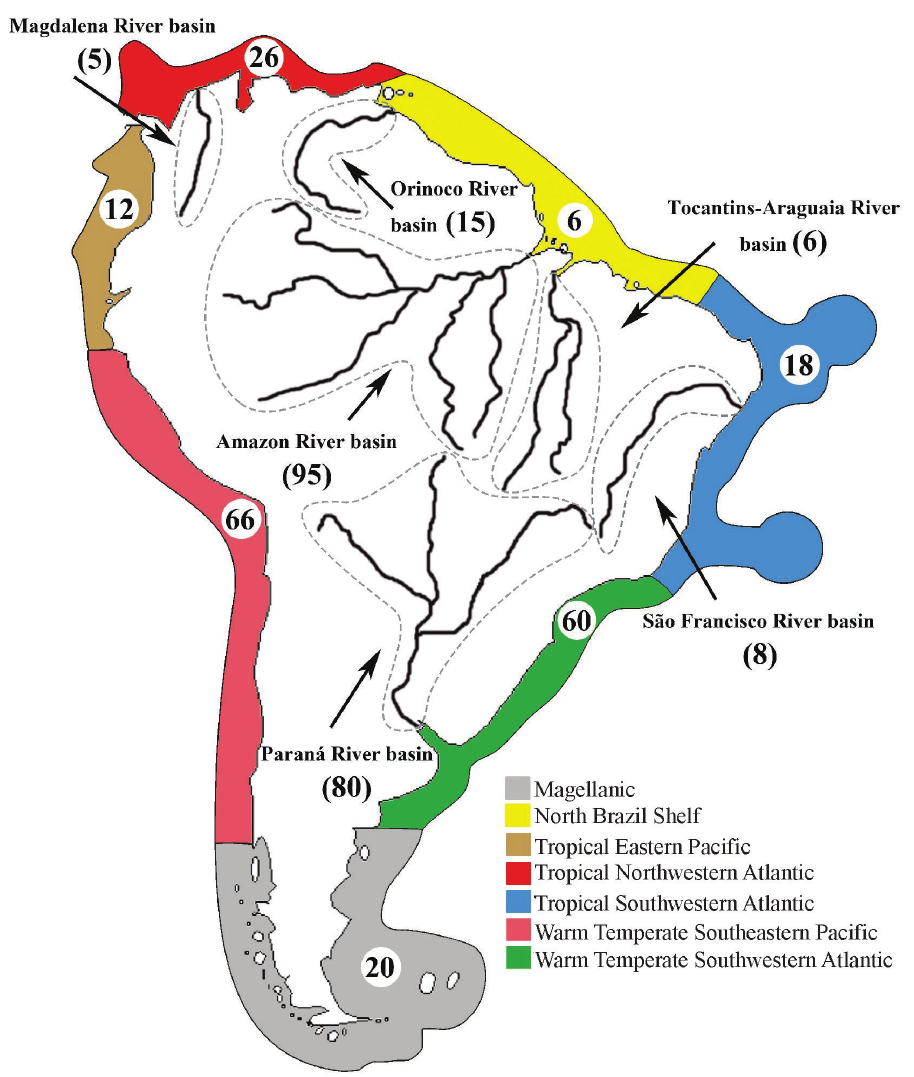
Figure 1. The geographical distribution of tapeworms in South America associated with their fish hosts from the major marine ecoregions of Spalding et al. (2007) and river basins in the continent. Each species may occur in more than one basin or